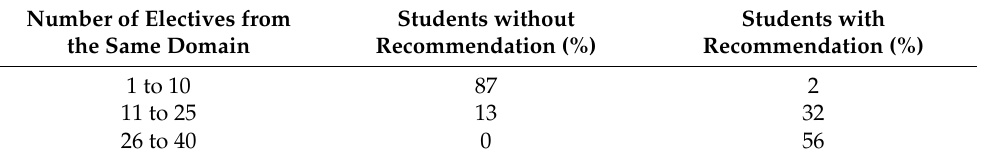
Table 7. Comparison of elective course selection patterns from same